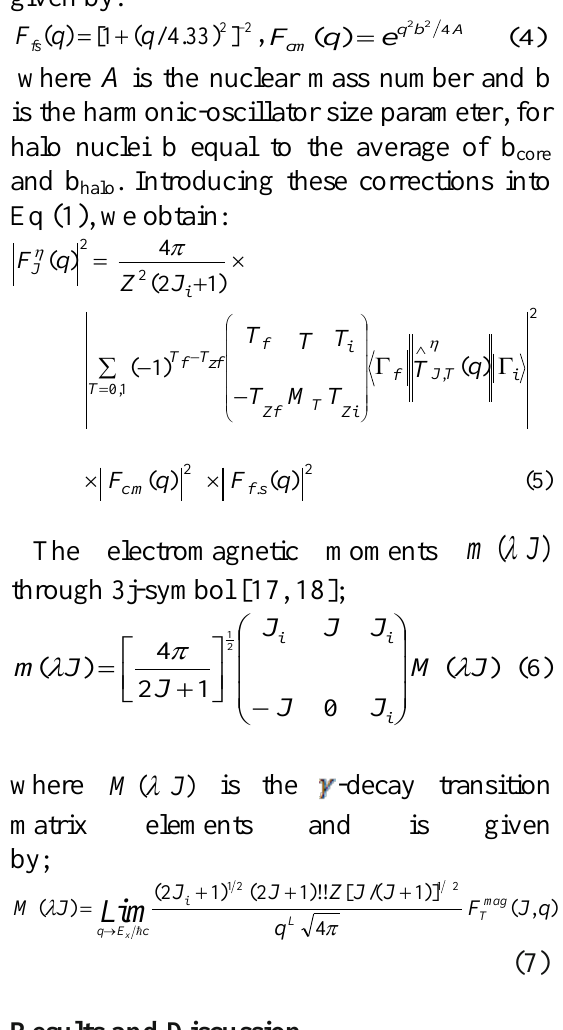
b =1.74fm (solid curve). The results are rms compared with the experimental data of Niftrik et al.[19] (squares) and with the data of Lichtenstadt et al .[20] (circles). The individual multipoles contributions M1 and M3 are denoted by dashed and dashed-dot curves respectively, while the E2 multipole is disappeared because it has a negligible contribution. The M1 and M3 multipoles can be easily distinguished, since they peak at different locations of q (around 0.5 and